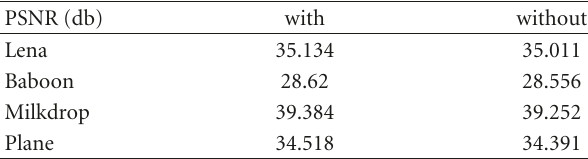
Table 2: PSNR of color images embedded by IA-LSB at 0.45 bpc. PSNR (db)